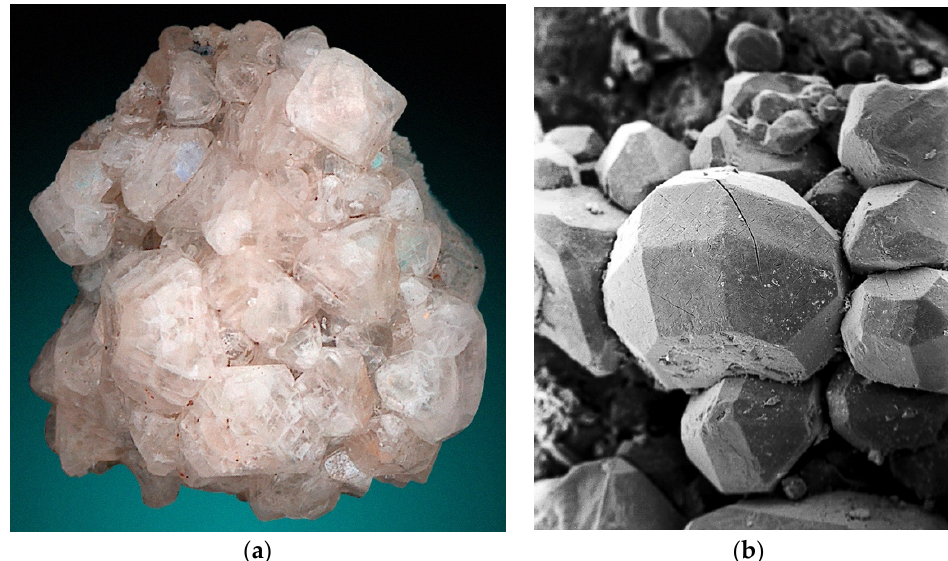
Figure 2. Aggregates of natrophosphate crystals from Mt. Koashva, Kola peninsula, Russia: ( a ) microphoto (field of view = 1.8 × 2 cm 2 ); ( b ) scanning electron microscopy (SEM) image (field of view = 1.1 × 1.2 mm 2 ).